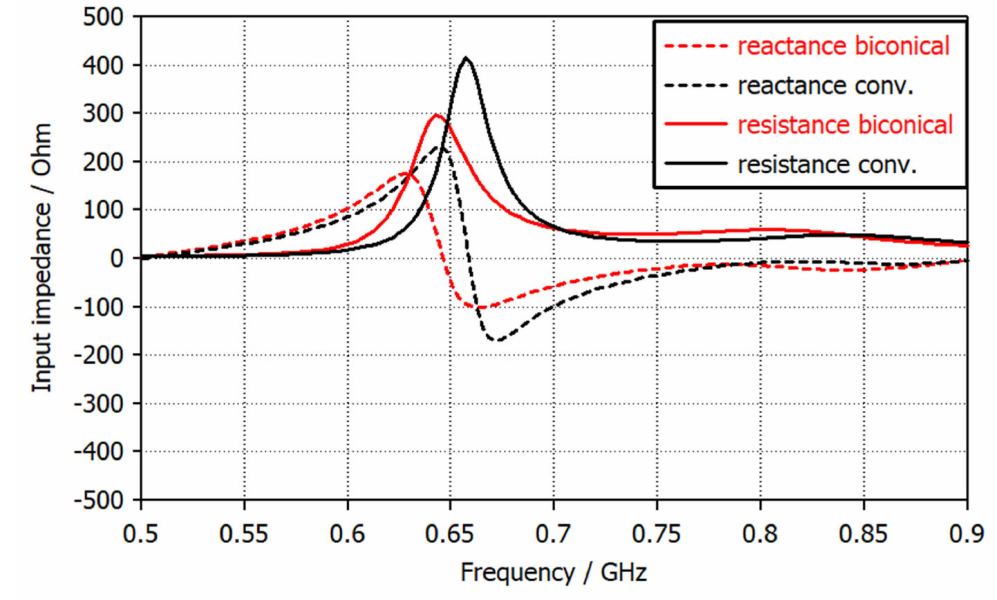
Figure 4. Input impedance versus frequency for conventional dipole and biconical